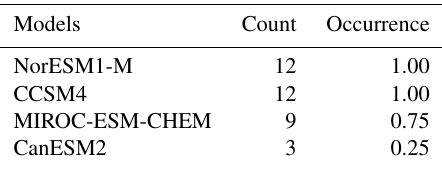
Table C2. Absolute and relative occurrence of each individual model included in the Antarctica top three combinations presented in Table C1.